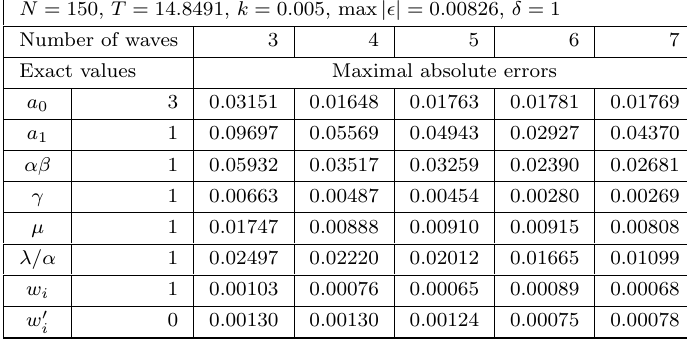
Table 1. Maximal absolute errors (wave profile, macrodeformation only). N = 150, T = 14 . 8491, k = 0 . 005, max | (cid:15) | = 0 . 00826, δ =